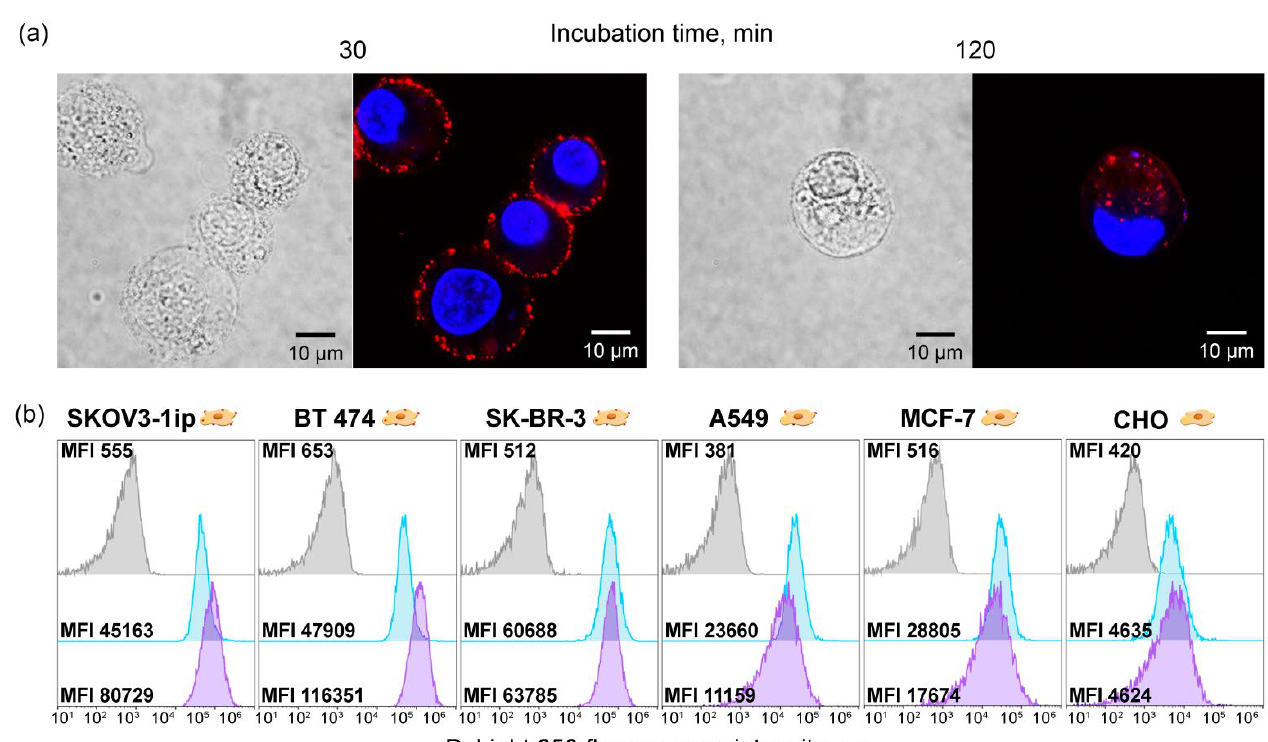
Figure 5. Imaging modalities of Ag-PEG-HER2 nanoparticles. ( a ): Visualization of the internalization of Ag-PEG-Z HER2:342 NPs in SKOV3-1ip cells after incubation for 30 (left panels) and 120 (right panels) min using two-channel confocal microscopy. Cell nuclei are stained with Hoechst33342 (blue), and NPs are labeled with DyLight650 (red). ( b ): Flow cytometry histograms of SKOV3-1ip, BT474, SK-BR-3, A549, MCF-7, and CHO cells showing the cell interaction with Trastazumab-DyLight650 and Ag-PEG-HER2*DyLight650. Gray—cell autofluorescence; blue—cells labeled with Trastuzumab; and violet—cells labeled with Ag-PEG-HER2*DyLight650 nanoparticles.